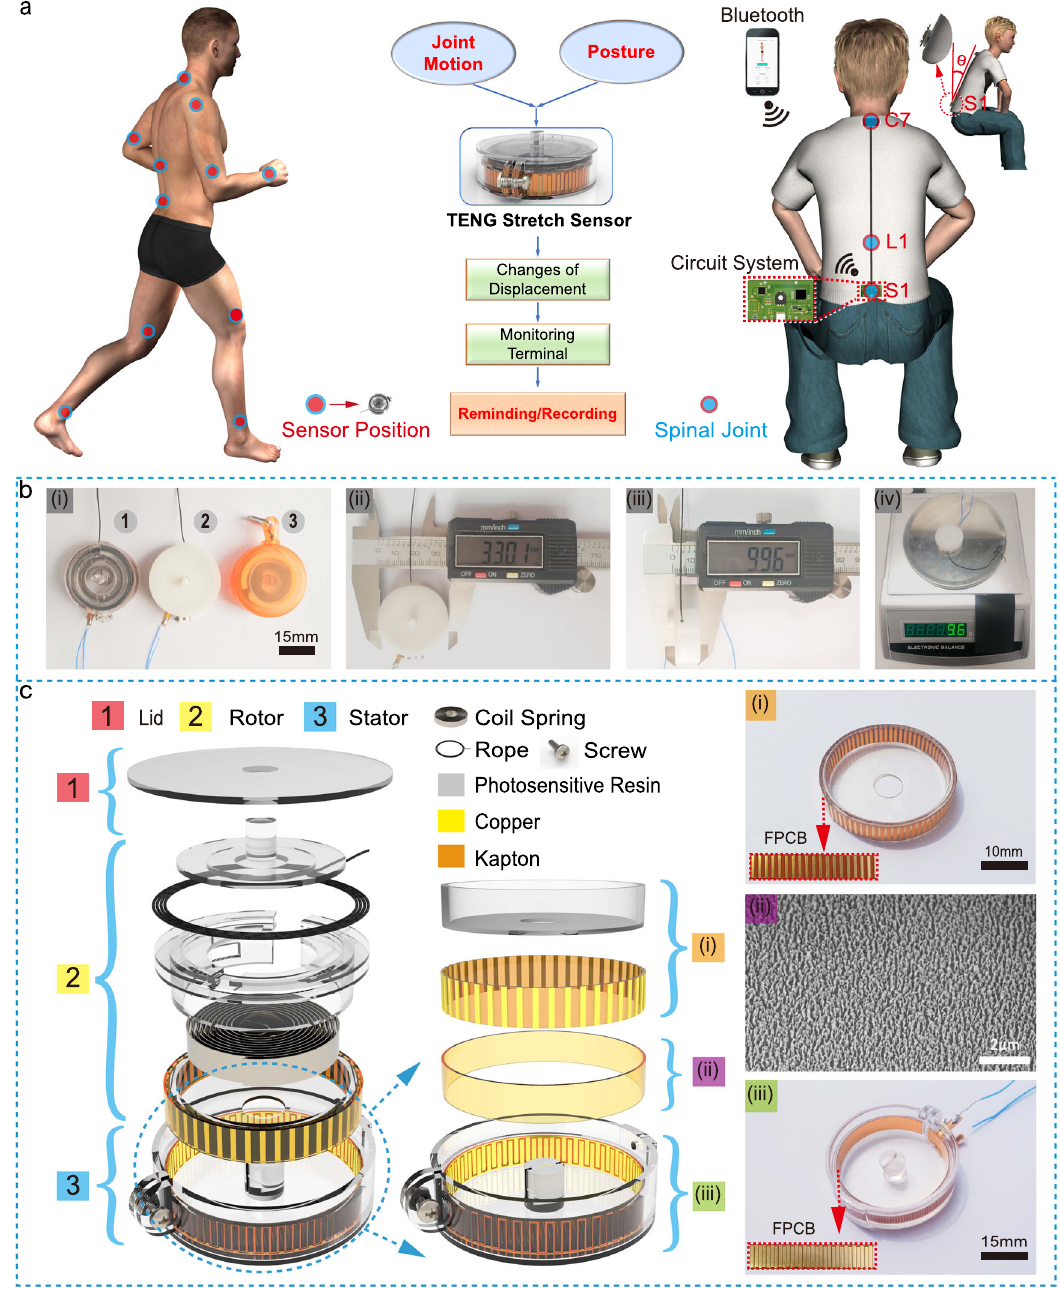
Fig. 1 Concept illustrations, schematic diagrams, photographs, and exploded view of the stretch sensor. a Illustration of the thin, lightweight, and wearable stretch sensor placed around the full body to monitor the joint and spinal motions, with continuous, wireless monitoring ability. b Images from a top view showing (i) the representative stretch sensors made up of two different 3D printing materials, i.e., photosensitive resin (1) and white resin material (2), and (3) displays a commercial retractable badge reel. In addition, the diameter (ii) and height (iii) of the sensor are shown. c Exploded view of the stretch sensor, consisting of (1) lid, (2) rotor, and (3) stator, and enlarged images: (i) the rotor electrode, (ii) etched nanorods on the surface of Kapton fi lm, and (iii) the stator